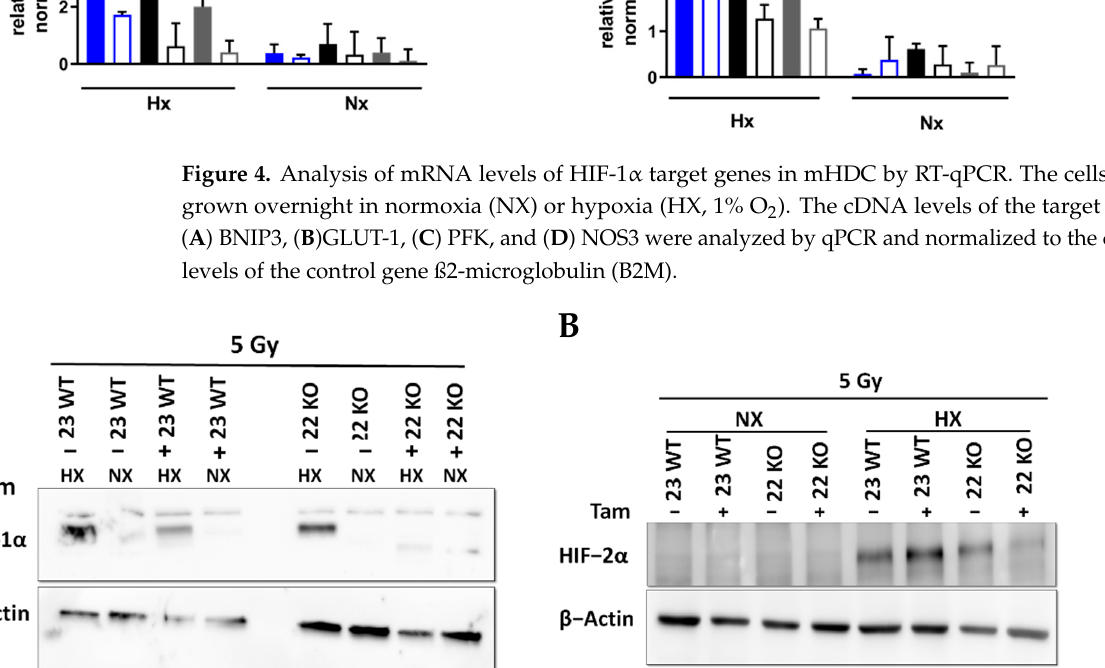
Figure 5. HIF-1 α ( A ) and HIF-2 α ( B ) Western blotting after 5 Gy irradiation. NX indicates normoxia, HX stands for hypoxia (1% O 2 ) for 4 h.